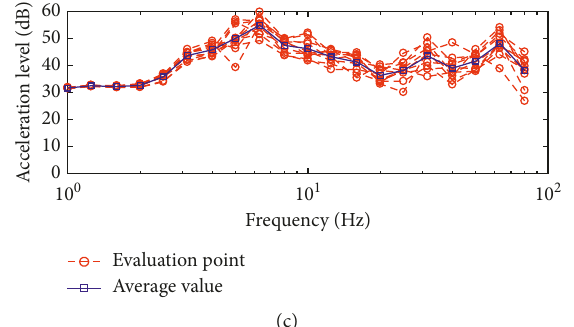
Figure 16: The one-third octave and average spectra of the accelerations of each evaluation point at typical story (6 th story, damping ratio 0.02). (a) X direction. (b) Y direction. (c) Z direction.